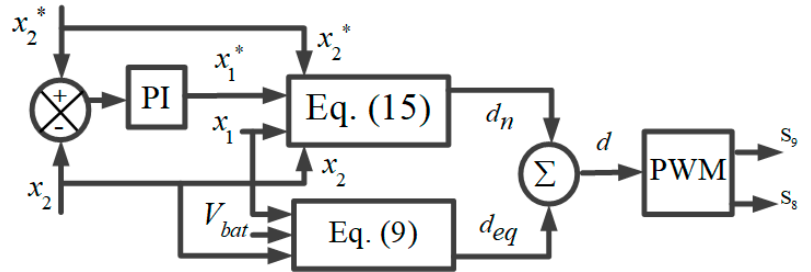
Figure 2. Control of the DC-DC buck boost converter.